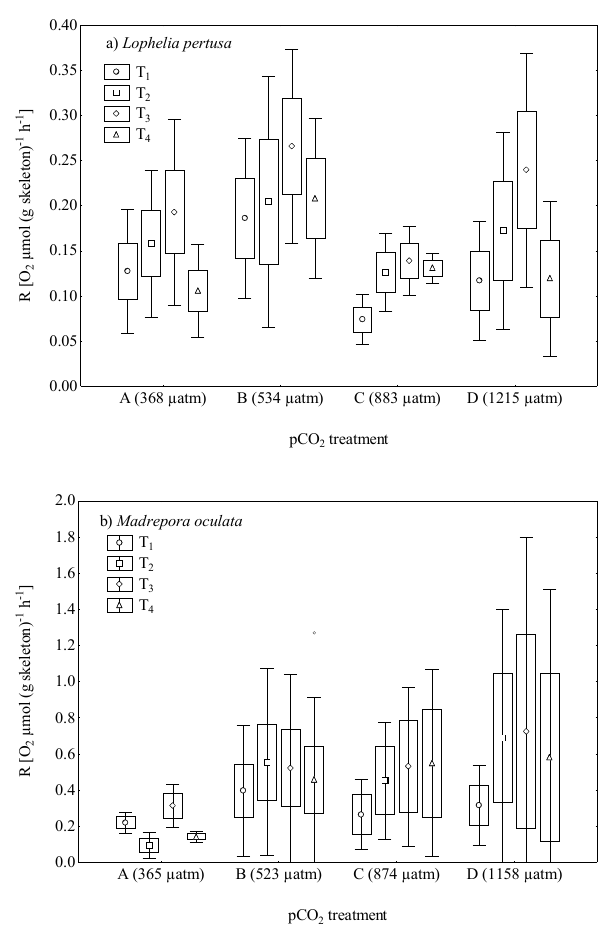
Fig. 1. Respiration rates of (a) L. pertusa (LP) and (b) M. ocu- lata (MO) for repeated measurements ( T 1 – T 4 ) at four p CO 2 treat- ments (A–D; see Tables 2 and 3). Values for p CO 2 treatments A–D (parentheses) are mean at end of incubation (Table